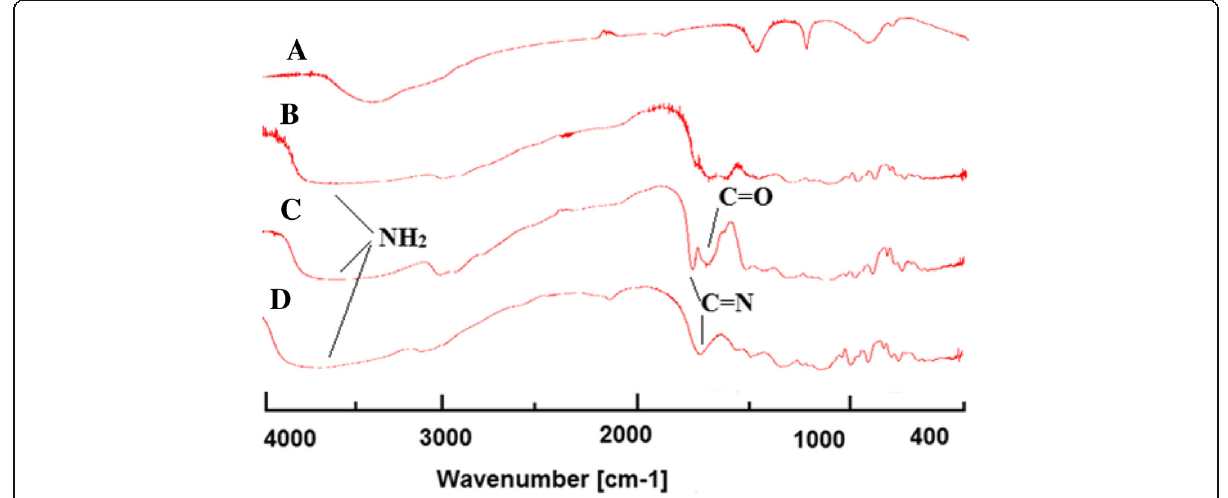
Fig. 12 FTIR for carrageenan ( a ), aminated carrageenan ( b ), activated carrageenan ( c ), and enzyme immobilized on carrageenan ( d )